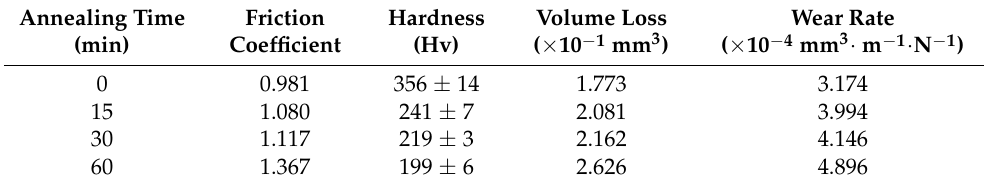
Figure 3. Plots for ( a ) friction coefficient and hardness, ( b ) volume loss and wear rate of CoCrNiSi 0.3 MEA under different annealing time. Table 1. Friction coefficient, hardness, volume loss, and wear rate of CoCrNiSi 0.3 MEA with different annealing times.